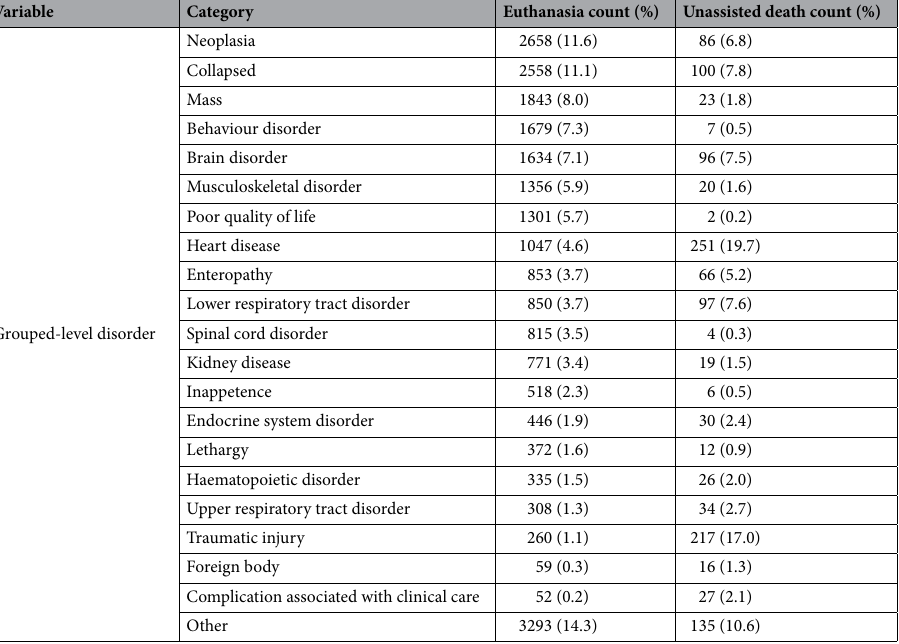
Table 1. Demography and causes of death for euthanased dogs (n = 26,676) and dogs that died unassisted (n = 2487) attending primary-care veterinary practices in the VetCompass Programme in the UK during 2016.